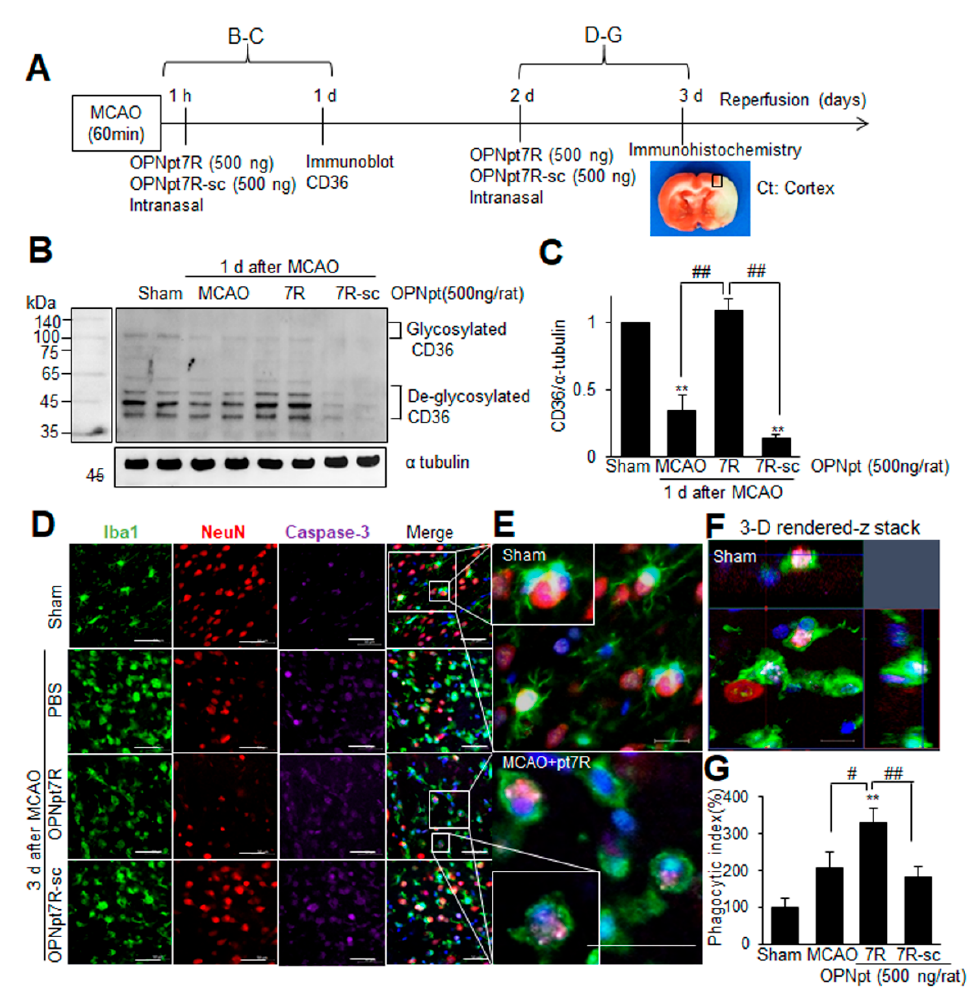
Figure 6. Enhanced phagocytic activity of microglia by OPNpt7R in the post-MCAO brain; ( A ) OPNpt7R (500 ng) or OPNpt7R-sc (500 ng) was administered intranasally at 1 h post-MCAO ( B , C ) or at 2 d post-MCAO ( D – G ). ( B , C ) Protein samples were prepared from the indicated region in A at 1 d post-MCAO, and the CD36 level was examined by immunoblot analysis. Representative images are presented ( B ) and quantified results are presented as the mean ± SEM ( n = 3) ( C ). ( D – G ) Coronal brain sections were prepared from sham, MCAO, MCAO+OPNpt7R, and MCAO+OPNpt7R-sc groups at 3 d after MCAO and processed for immunostaining with anti-Iba1, anti-NeuN, and anti-activated caspase 3 antibodies. Representative pictures are presented ( D – F ) and phagocytic index (the ratio of Caspase 3-encapsulated in Iba1 over Caspase 3 in regions (0.2 mm 2 ) indicated as black box in A are presented as the mean ± SEM ( n = 10, 10 brain slices from three animals) ( G ). The images in E are high-magnification photographs of images in the Sham and MCAO+OPNpt7R group (indicated as white boxes). Scale bars represent 50 µ m. Sham, sham-operated rats; MCAO, PBS-treated MCAO controls; MCAO+OPNpt7R, OPNpt7R-treated MCAO rats; MCAO+OPNpt7R-sc, OPNpt7R-sc-treated MCAO rats. ** p < 0.01 vs. PBS-treated MCAO controls, and # p < 0.05, ## p < 0.01 between indicated